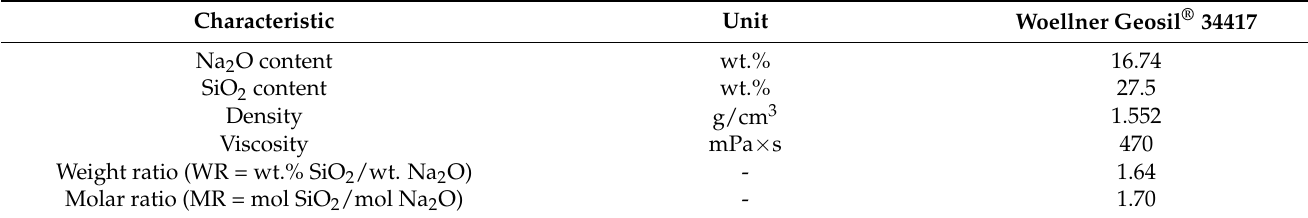
Table 2. Chemical composition of Geosil ®